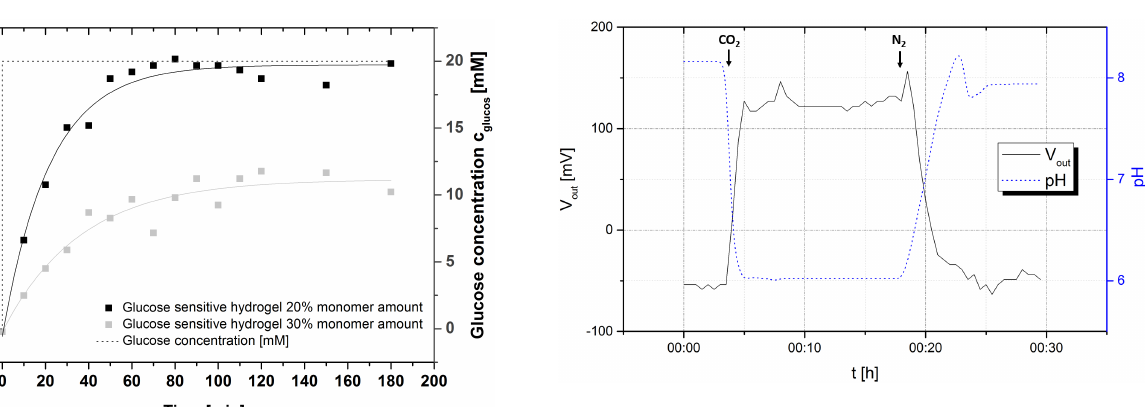
Figure 5. Sensor output voltage during the swelling of a HPMA/DMAEMA/TEGDMA hydrogel in 17mM NaHCO 3 while changing the pH through CO 2 and N 2 supply.